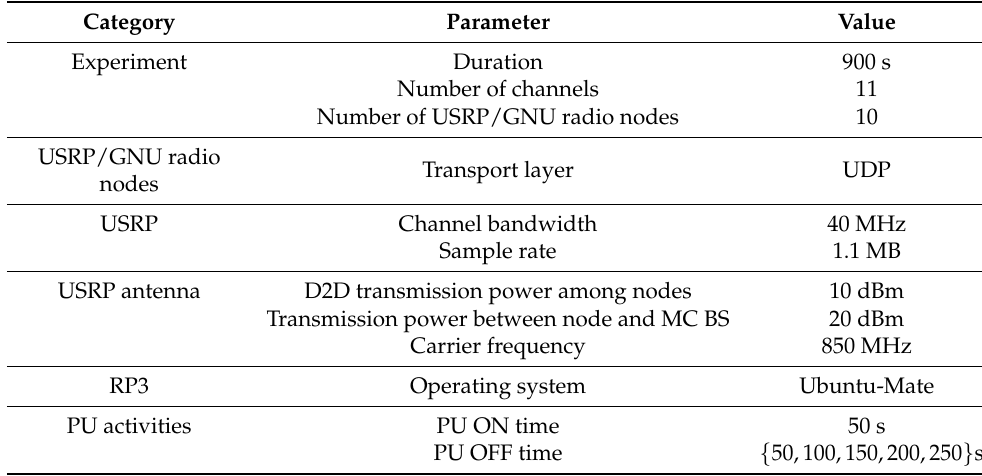
Table 2. Experimental setup